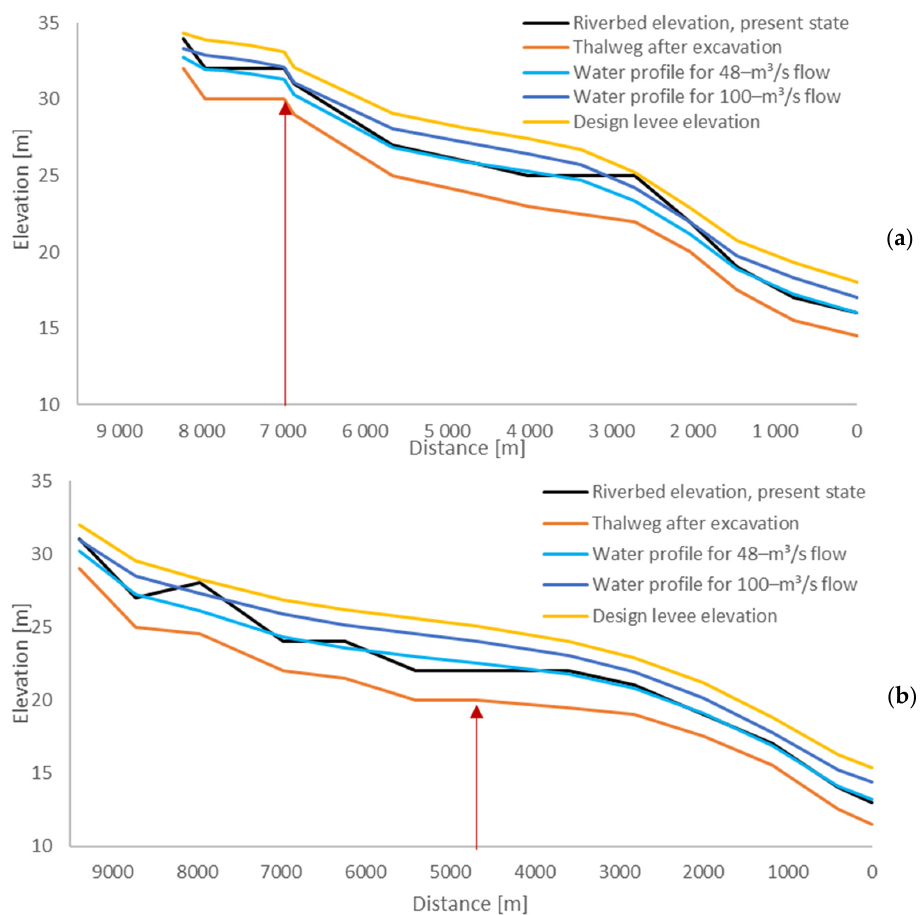
Figure 12. ( a ) Water profile of reach a and c computed in steady condition with the flow rate of 48 m 3 /s and 100 m 3 /s. Comparison of the levee proposed and the present state of the system. The red arrow indicates the position of the river junction. ( b ) Analogous depiction for reach b. The red arrow here indicates the position of the lateral structure connecting the river to the natural basin.